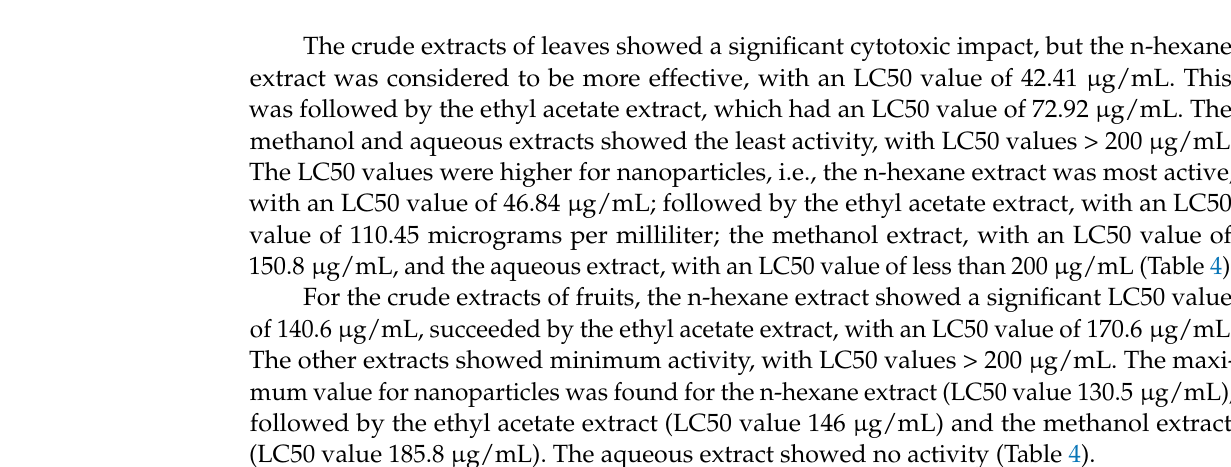
Positive Controls